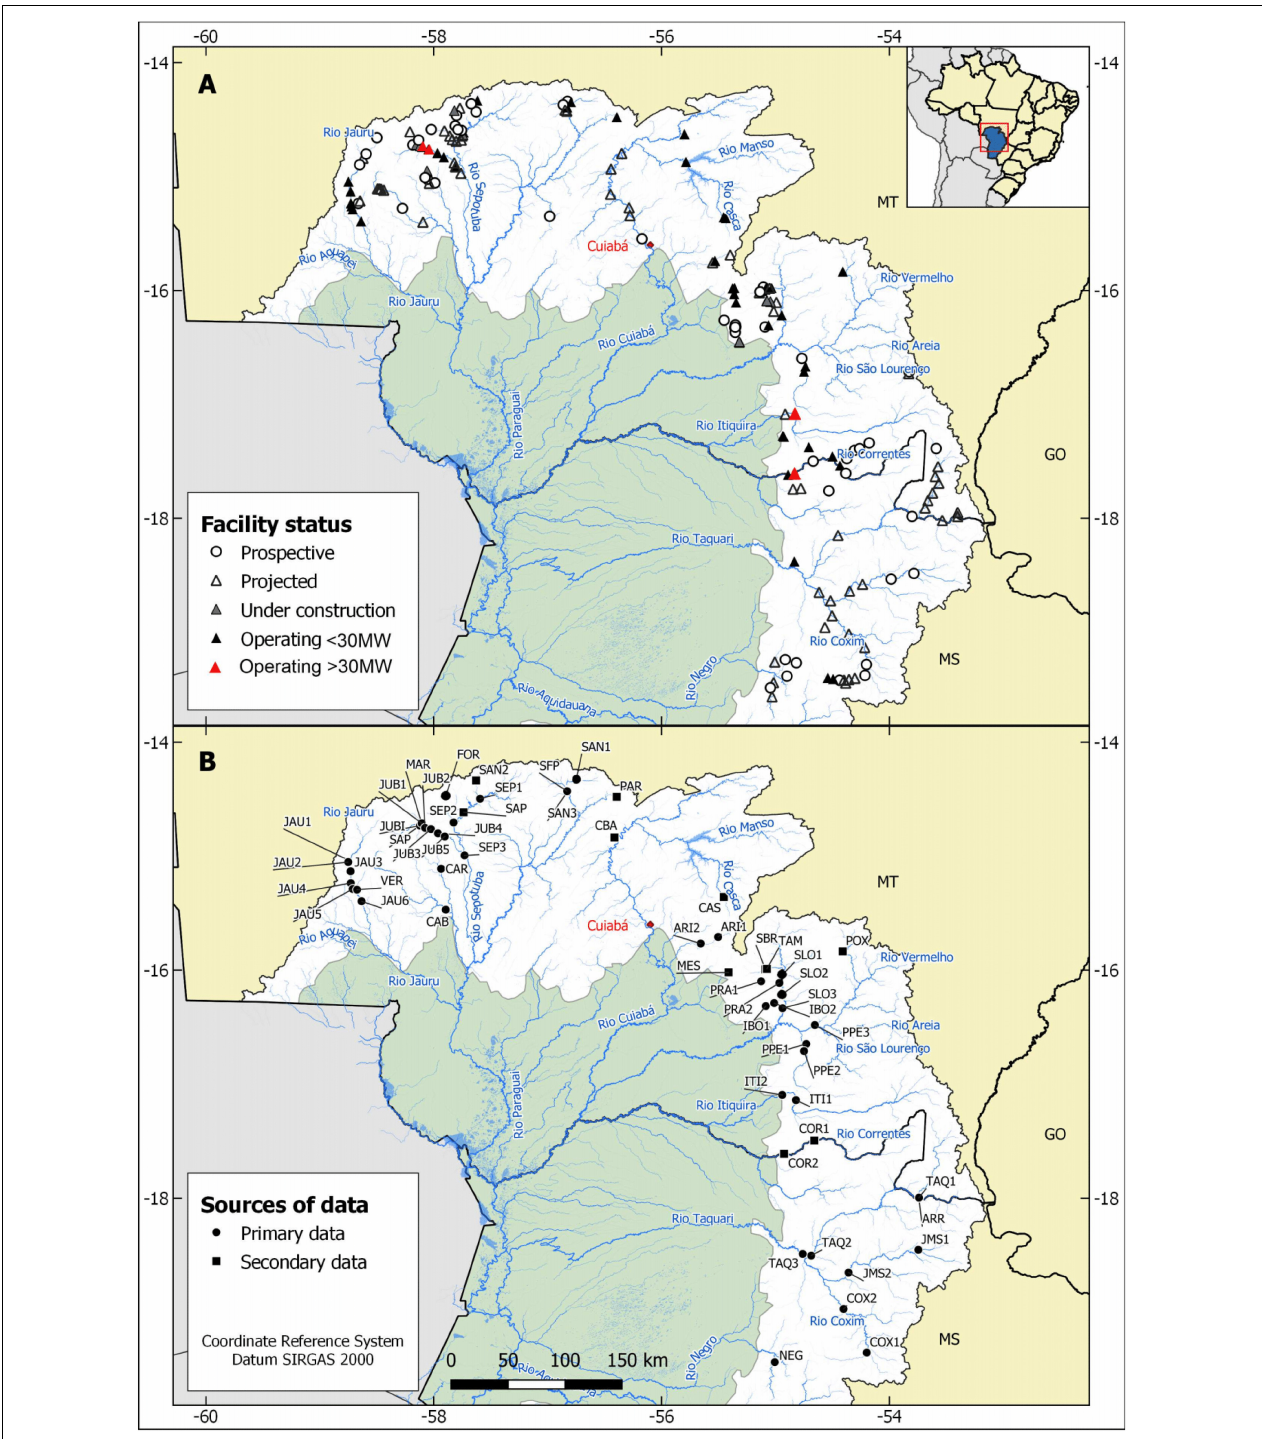
FIGURE 1 | (A) Hydropower facilities in the upland watershed of the Pantanal that are currently in operation as well as future projects that are under construction, planned, or identified as potential sites for hydropower development by either the Brazilian National Electric Energy Agency (ANEEL) or the state environmental agencies (depending on location). Red triangles indicate the four studied facilities with installed capacities > 30 MW. (B) Sampling sites for nutrient transport, including sampling conducted by the authors (primary data) as well as secondary data derived from environmental compliance reports submitted to state agencies (SEMA-MT and IMASUL) and from previous scientific studies. The Pantanal floodplains are shaded in green and rivers ( rios ) and other waterbodies are shown in blue. Sampling site acronyms are identified in Table 1 .